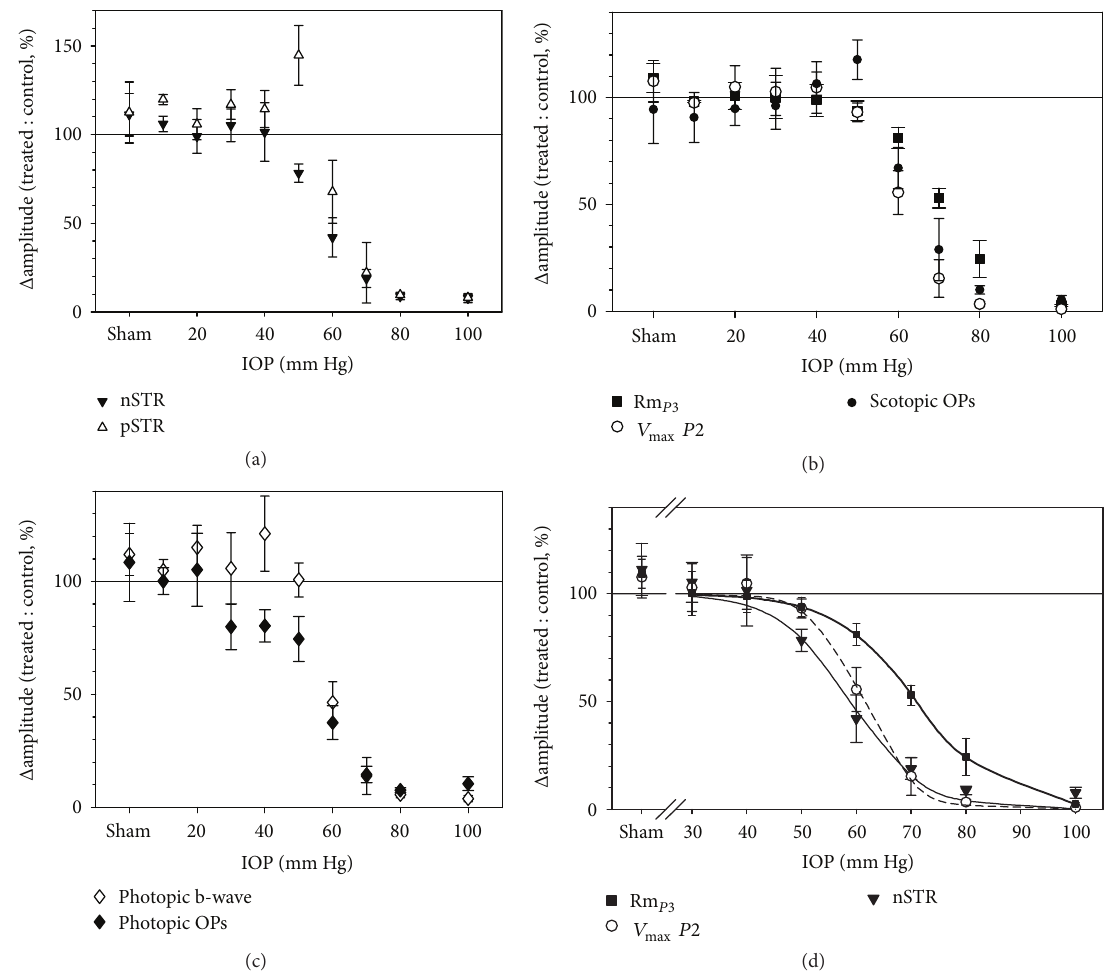
050100 Photopic b-wave Photopic OPs F 4: Relative change in ERG amplitude versus IOP (mean SE�). (a) Positive STR (pSTR, un�lled triangles) and negative STR (nSTR, , �lled s�uares), amplitude ( , open circles), and scotopic OP amplitude (�lled �lled triangles). (b) Photoreceptoral amplitude (Rm circles). (c) Photopic b-wave amplitude (open diamonds) and photopic OP amplitude (�lled diamonds). (d) nSTR (�lled triangles, thin ± 𝑃𝑃𝑃 (open circles, dashed curve), and photoreceptoral Rm (�lled s�uares, bold curve) are replotted together with their solid curve), 𝑃𝑃𝑃 𝑉𝑉 max corresponding best-�t cumulative normal functions for comparison. Reprinted from [46] with permission. e Association for Research in 𝑃𝑃𝑃 Vision and Ophthalmology remains the copyright holder. 𝑃𝑃𝑃 𝑉𝑉 max IOP elevation at 70 mmHg compared with 50 mmHg. For IOP elevation to 50 mmHg (42 minutes) the